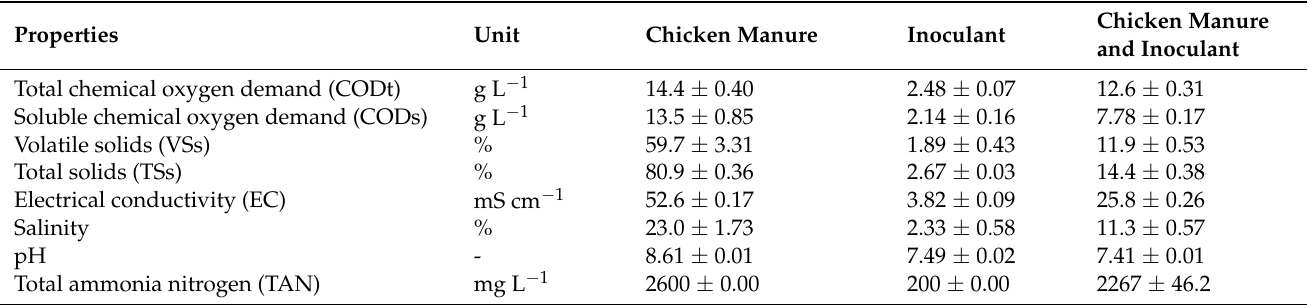
Table 1. Characteristics of chicken manure, inoculant and their mixture prior to anaerobic digestion (day 0), with the respective